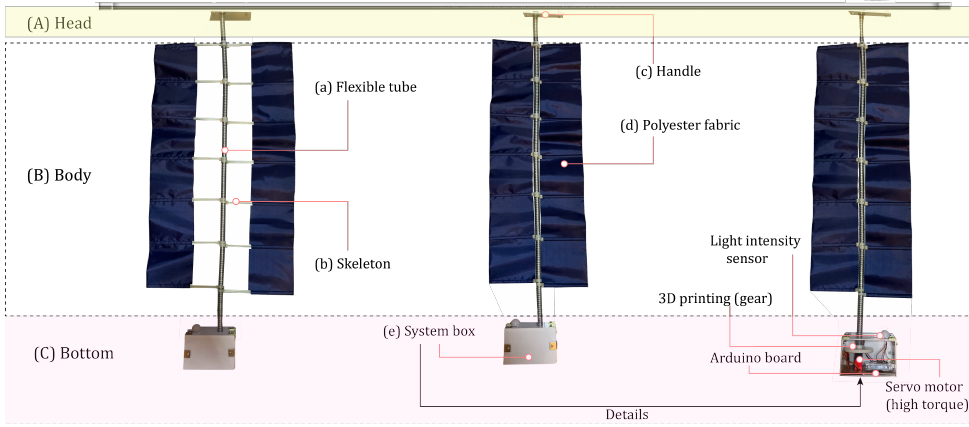
Figure 15. The kinetic façade (version 2: twisting movement)